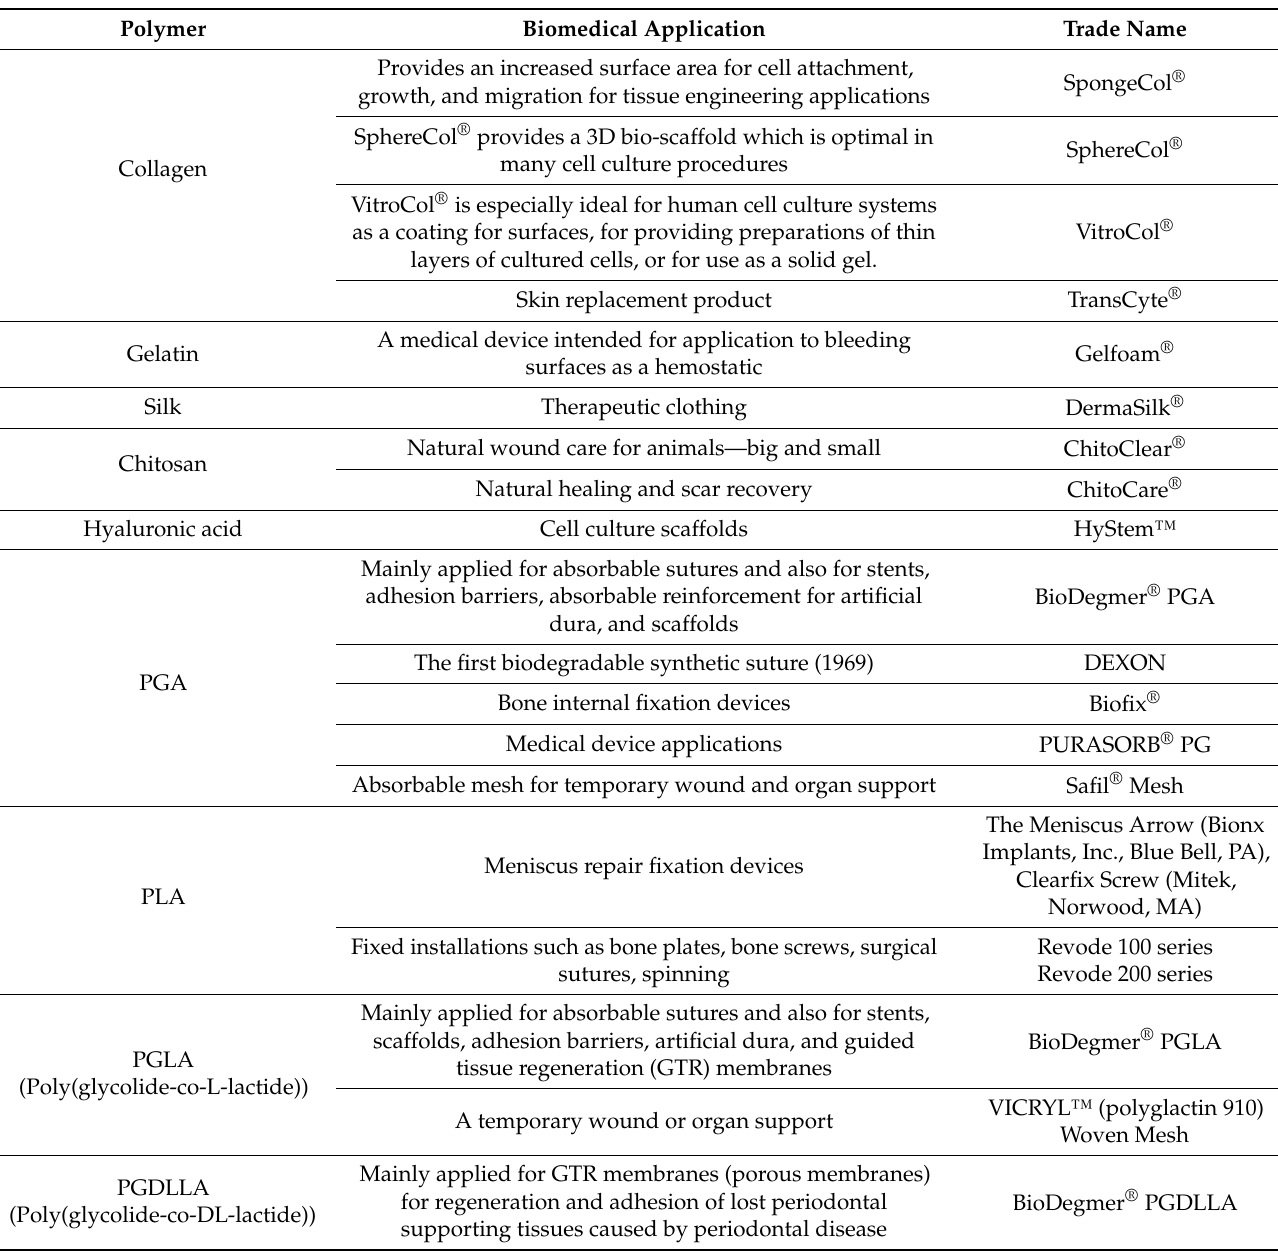
Table 7. Commercial biopolymers for different biomedical